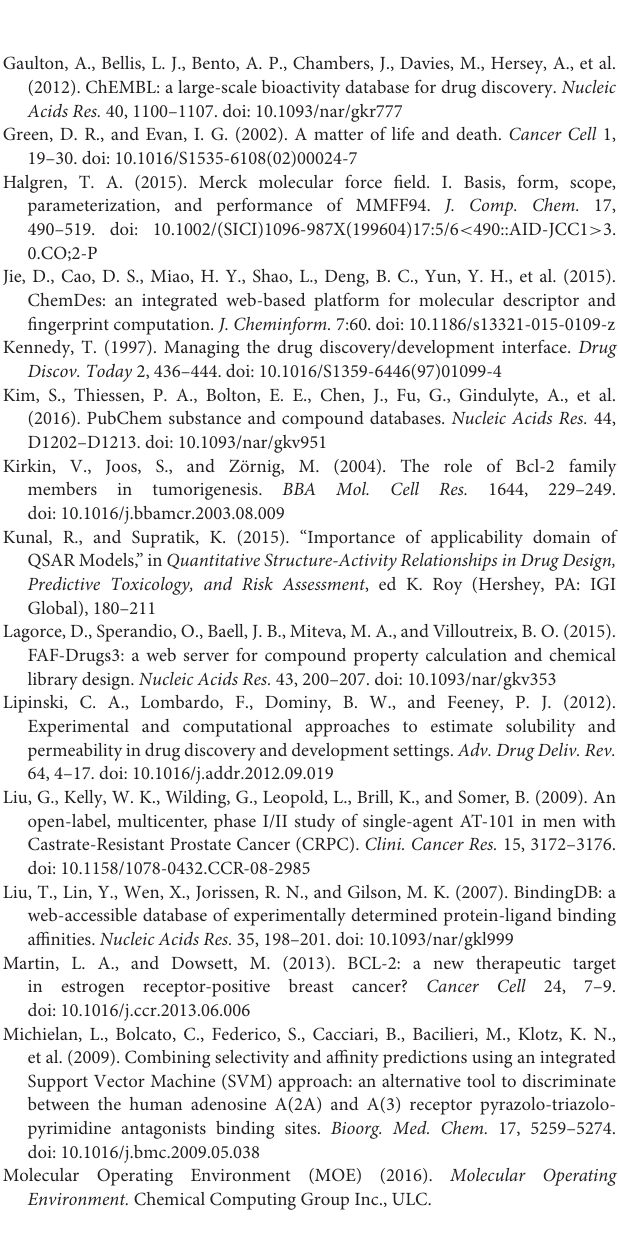
Figure S1 | The cytotoxic effects of eight small molecule compounds on breast cancer cells. MDA-MB-231 cells were treated with eight small molecule compounds for 48h. At the end of treatment, cell viability was measured by CCK-8